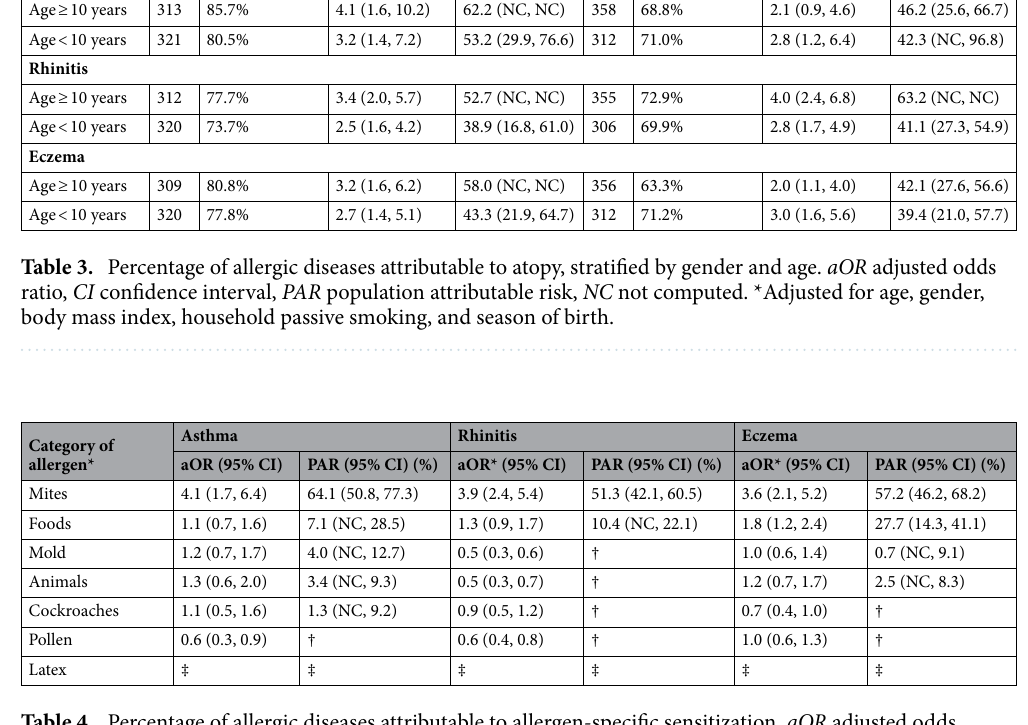
Table 4. Percentage of allergic diseases attributable to allergen-specific sensitization. aOR adjusted odds ratio, CI confidence interval, PAR population attributable risk, NC not computed. *Each allergen category was independently analyzed. † PAR were not calculated because the aOR was < 1.0 17 . ‡ aOR and PAR were not calculated for latex due to its low prevalence which resulted in non-convergence of the model 28